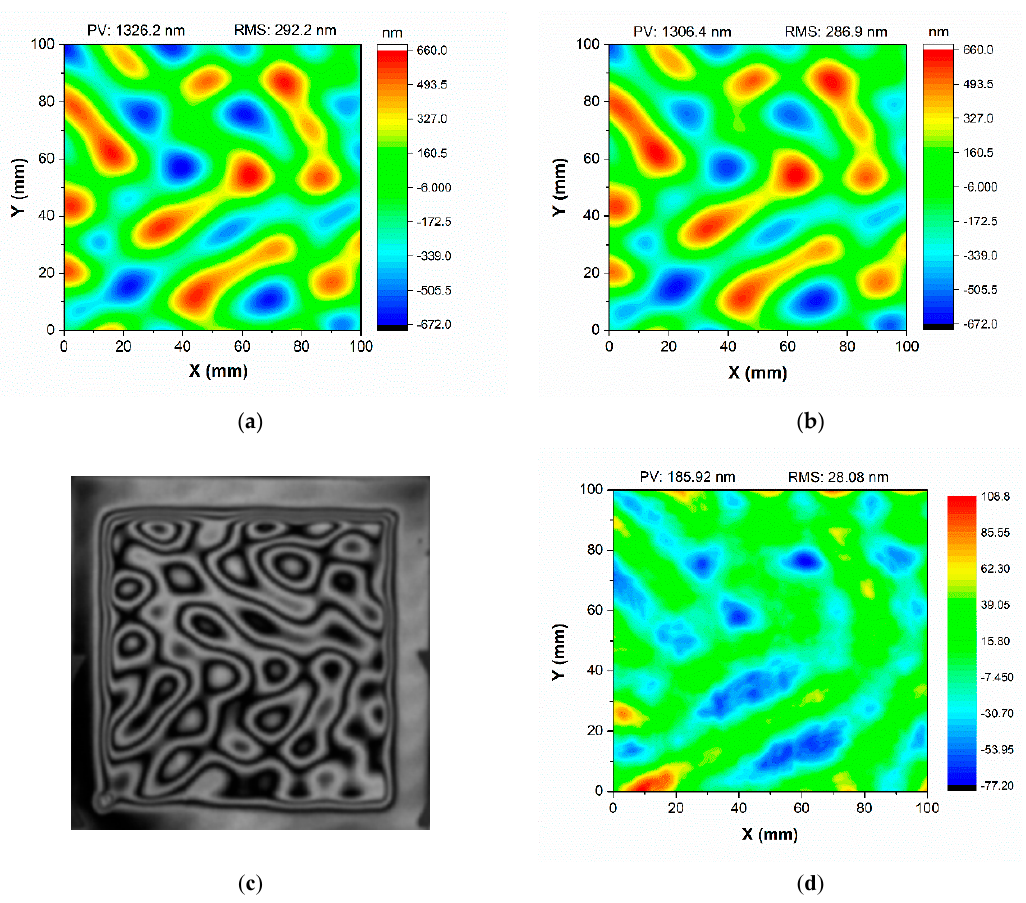
Figure 6. Machining example of a CPP substrate: ( a ) prescribed surface: PV = 1326.2 nm, RMS = 292.2 nm; ( b ) plasma- processed surface, PV = 1306. 4 nm, RMS = 286.5 nm; ( c ) interferometer measurement; ( d ) plasma-processed residual errors of the CPP.